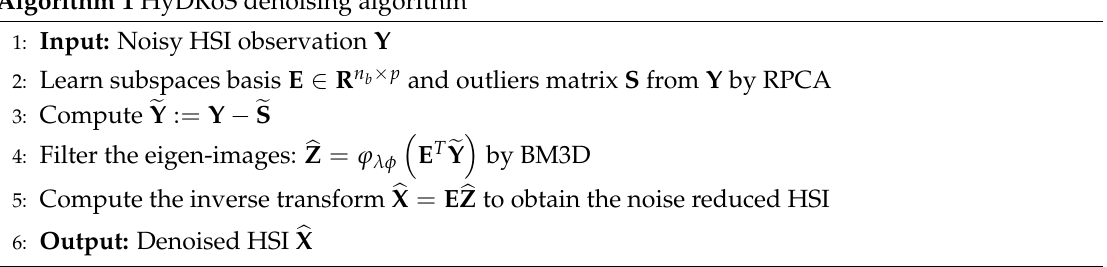
Algorithm 1 HyDRoS denoising